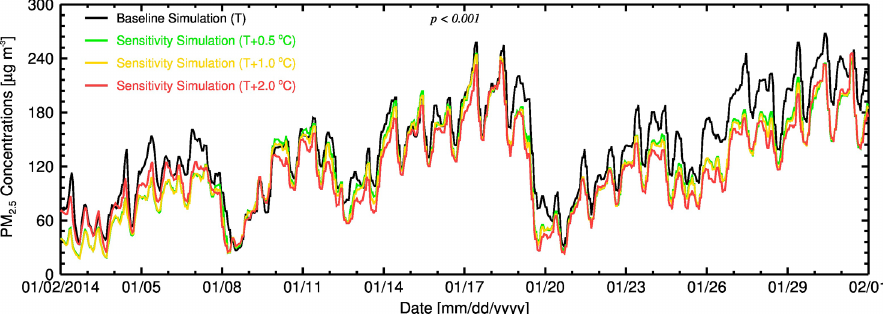
Figure 5. Time series of PM 2 . 5 concentration over the Sichuan Basin. The baseline simulation is selected in January 2014 and the sensitivity simulations in which 0.5, 1.0 and 2 ◦ C warming occur over the Tibetan Plateau relative to the baseline simulation. The differences in PM 2 . 5 concentrations between the baseline simulation and sensitivity simulations are significant, exceeding the 99.9% confidence level ( p < 0 .